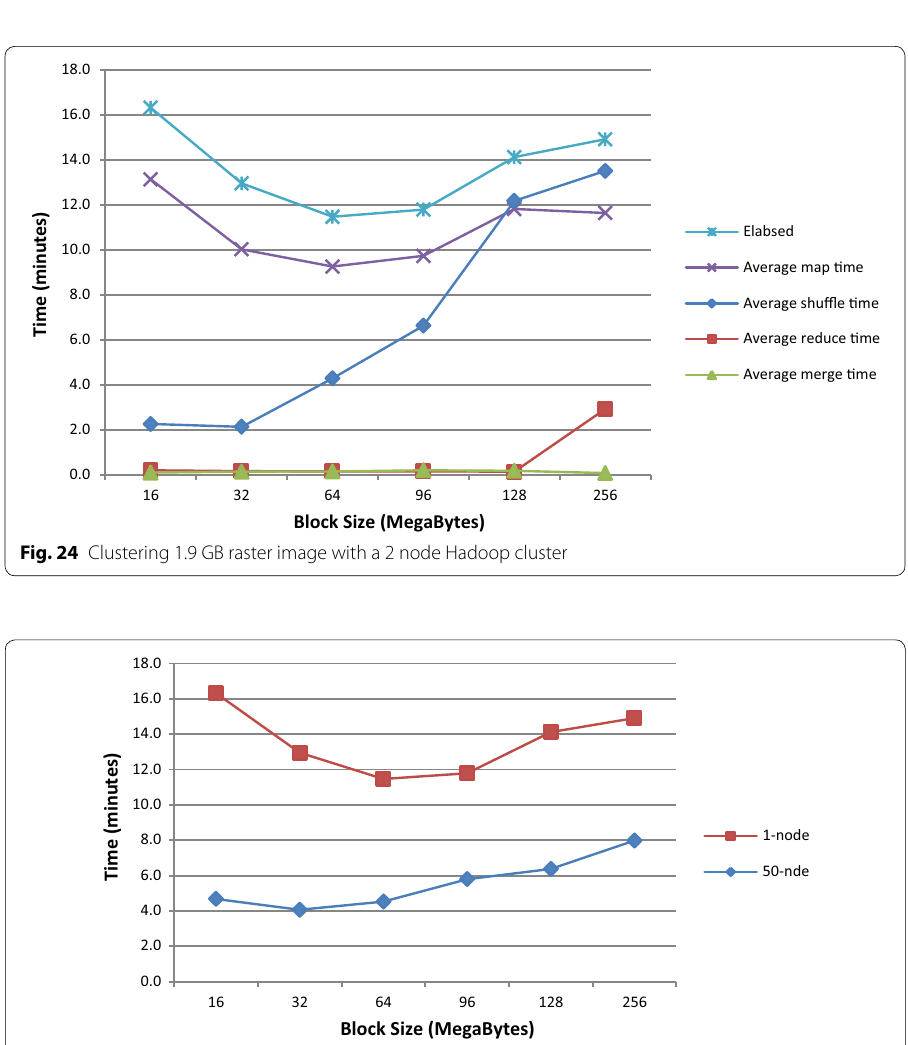
Fig. 25 Comparing the elapsed time for running k-means with 1.9 GB raster image in 2 and 50 nodes Hadoop